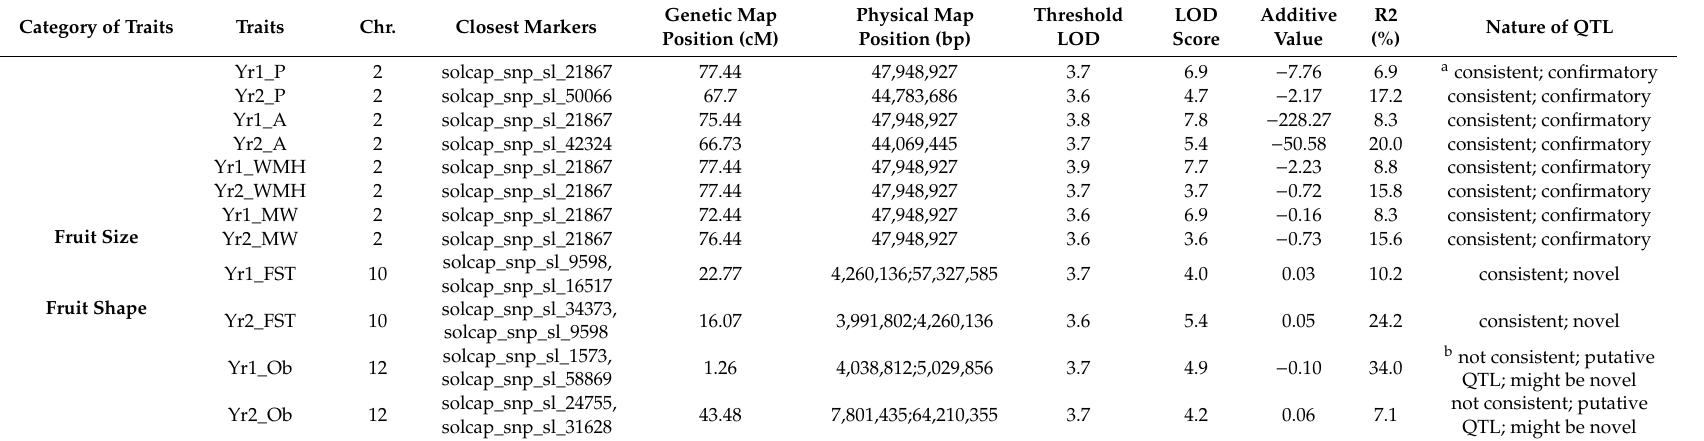
Table 6. Summary of QTL information detected across di ff erent generations in NC10204 population of tomato controlling fruit size and shape. The table presents the position of the QTL in genetic map and physical map, flanking SNP molecular markers, LOD score value and phenotypic variation explained by each QTL (R 2 -value), additive e ff ect, and if the QTL has been previously identified or novel. Y1 indicates the year 2014 (F 2:3 generation), and Y2 indicates the year 2017 (F 5:6 generation). The positive additive e ff ects were associated with the parent NC 30P, and negative additive e ff ects were associated with the parent NC 22L-1(2008). The physical map position of the markers was obtained from the Solanaceae Genome Network (SGN; http: // solgenomics.net). Category of Traits Traits Chr. Closest